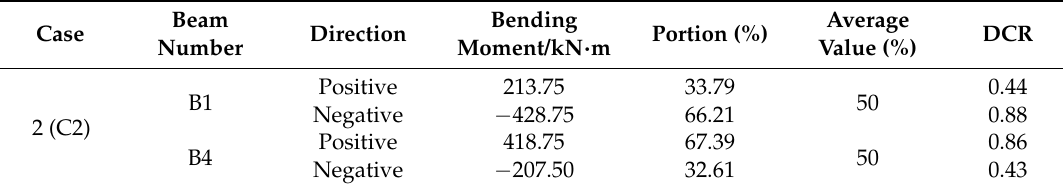
Table 10. Force condition of beams in cases 2, 3, 4 and